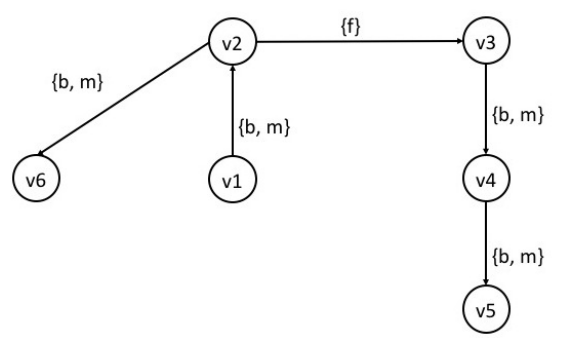
Figure 20. QCN when temporal entities are